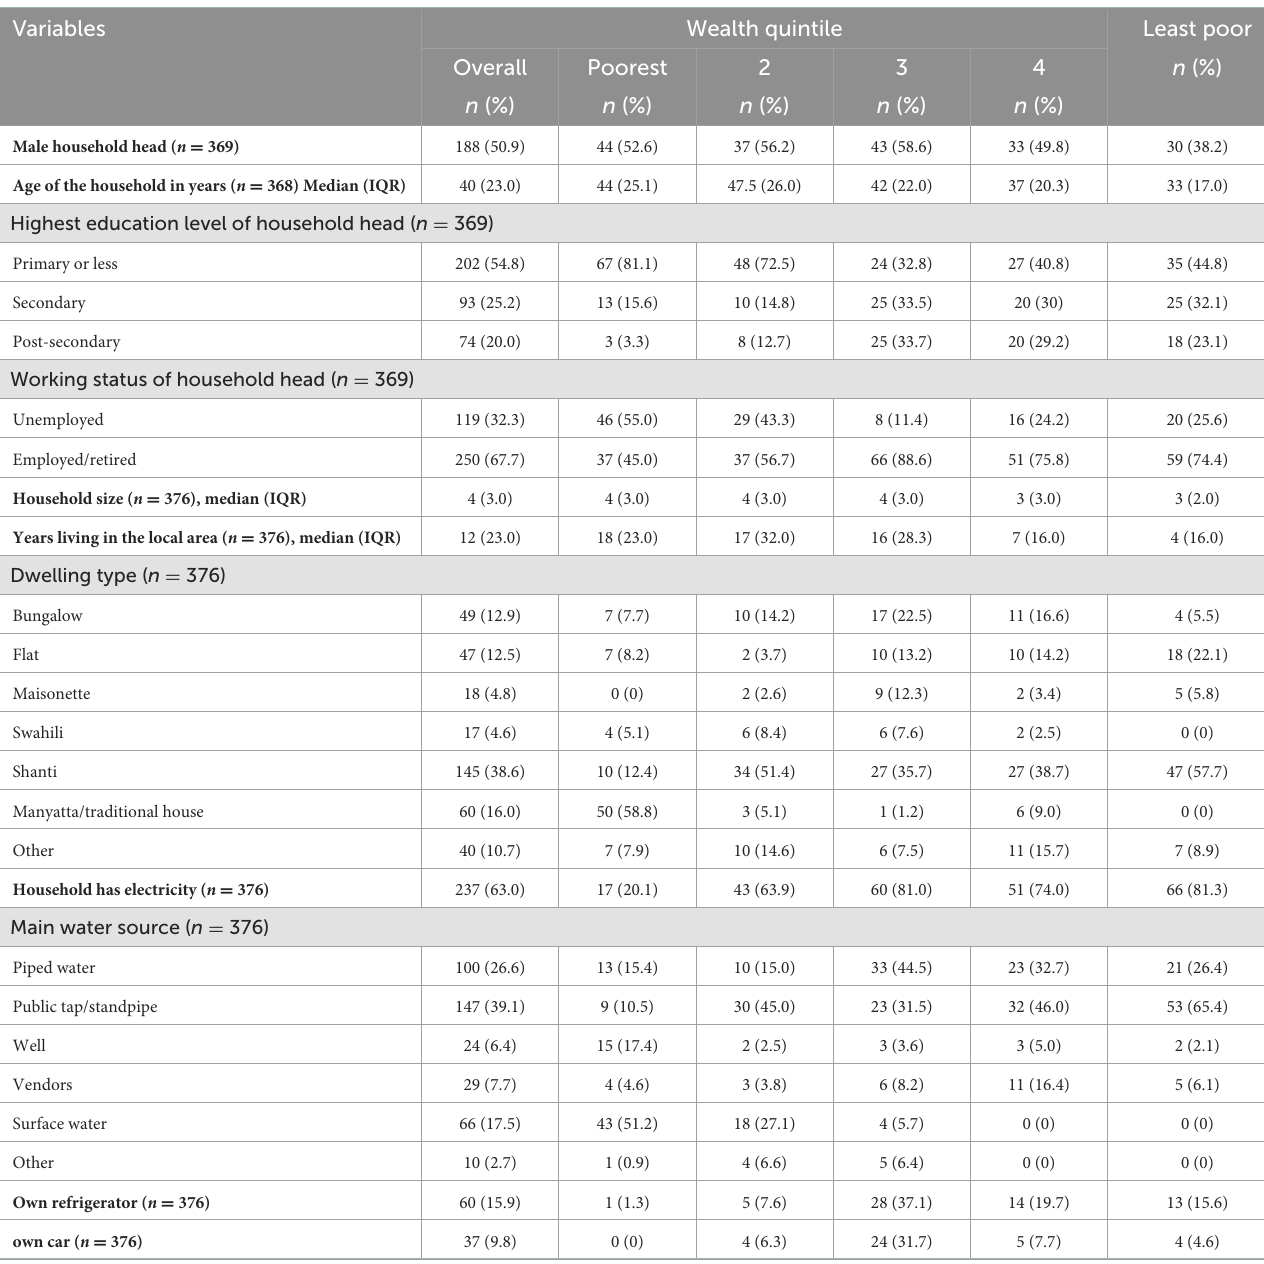
TABLE 2 Characteristics of the households by socioeconomic status ( n =